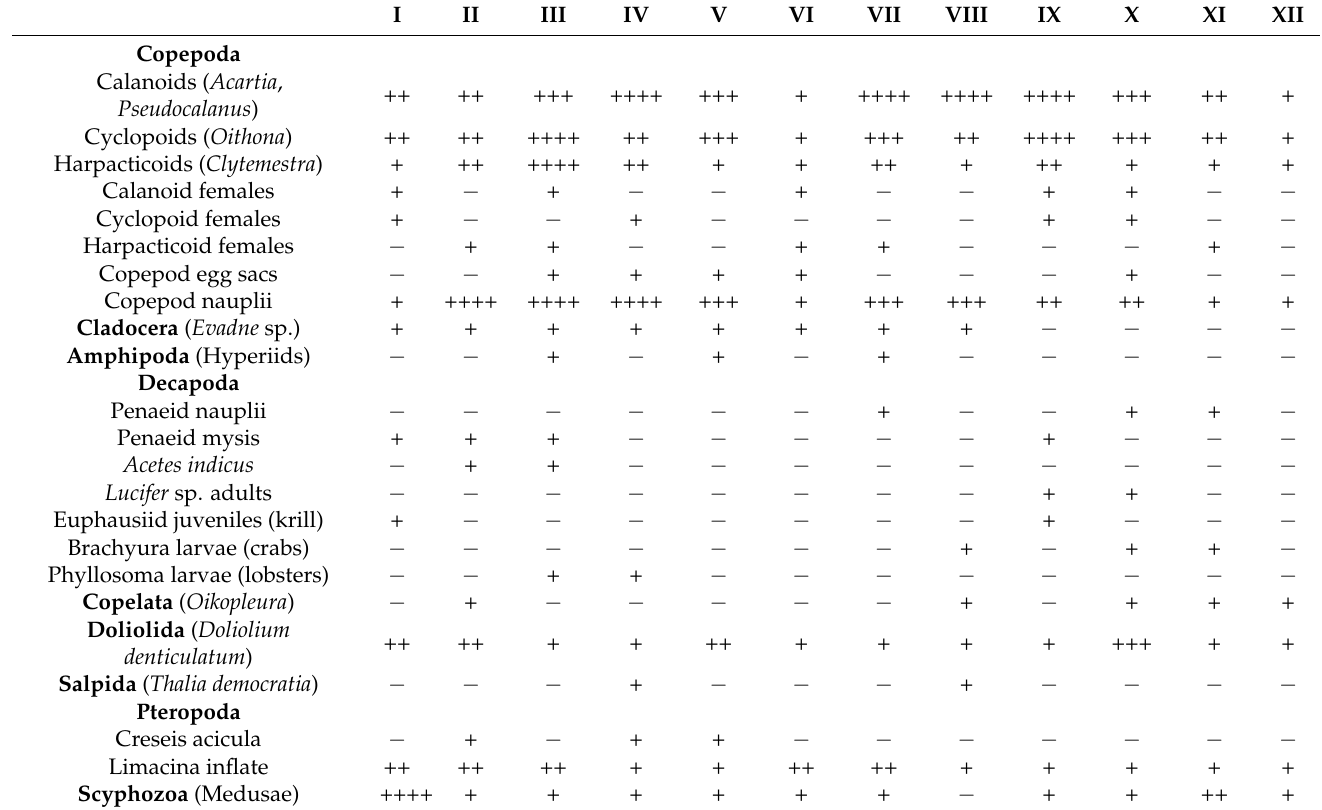
Table 7. Monthly distribution and abundance of zooplankton species/taxa recorded in seawater ponds at Garho Fish